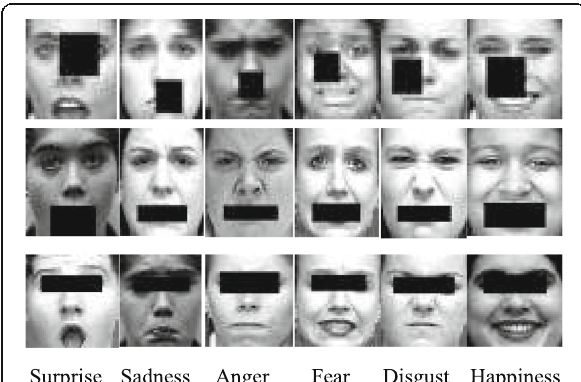
Fig. 5 Cropped face images of six facial expressions with occlusions from the CK+ dataset